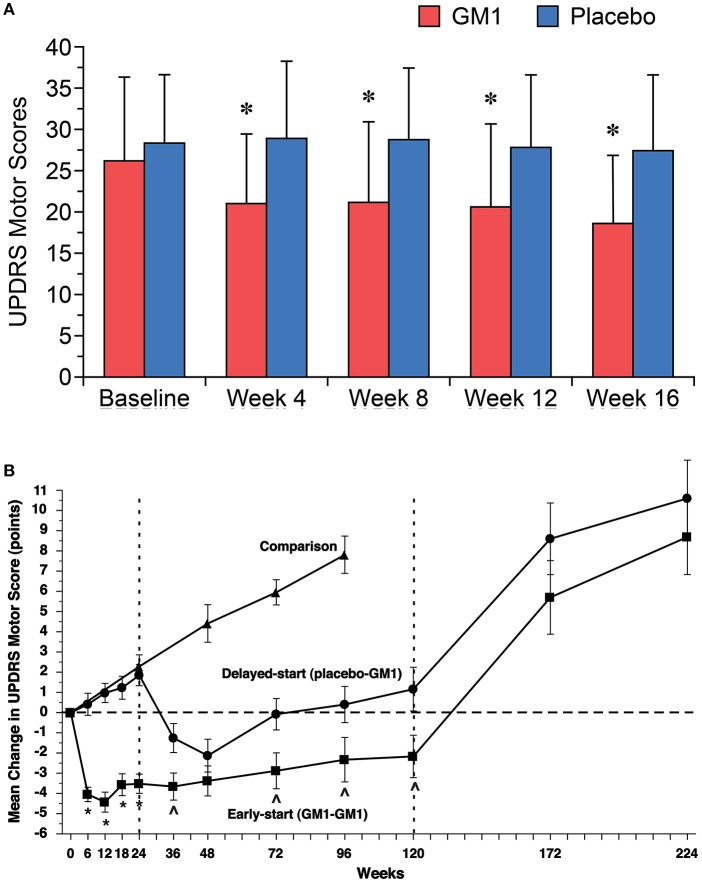
(A) Significant improvements in mean (±SD) Unified Parkinson's Disease Rating Scale (UPDRS) motor scores were noted in GM1-treated patients (red bars) beginning after 4 weeks of treatment and were maintained during the 16-week study. Mean UPDRS motor scores for the placebo group (blue bars) did not change significantly. Asterisks represent significant difference from baseline within the GM1 group. [Reprinted with permission from: Schneider et al. (106). https://n.neurology.org/content/neurology/50/6/1630.full]. (B) Changes in Unified Parkinson's Disease Rating Scale (UPDRS) Motor Subsection scores in a delayed start trial of GM1 in PD. The mean (±SE) change from baseline (observed scores) in Early-start and Delayed-start study subjects and in the standard-of-care Comparison group, assessed in the practically defined “off” condition. The dashed vertical line at week 24 indicates the end of study Phase I. The dashed vertical line at week 120 indicates the end of study Phase II. The horizontal dashed line indicates baseline level. An increase of score indicates symptom worsening; a decrease in score indicates symptom improvement. These data suggest a potential disease modifying effect of GM1 on PD. *p < 0.0001 Early-start vs. Delayed-start; p < 0.05 Early-start vs. Delayed-start. [Reprinted from Schneider et al. (107), with permission from Elsevier].